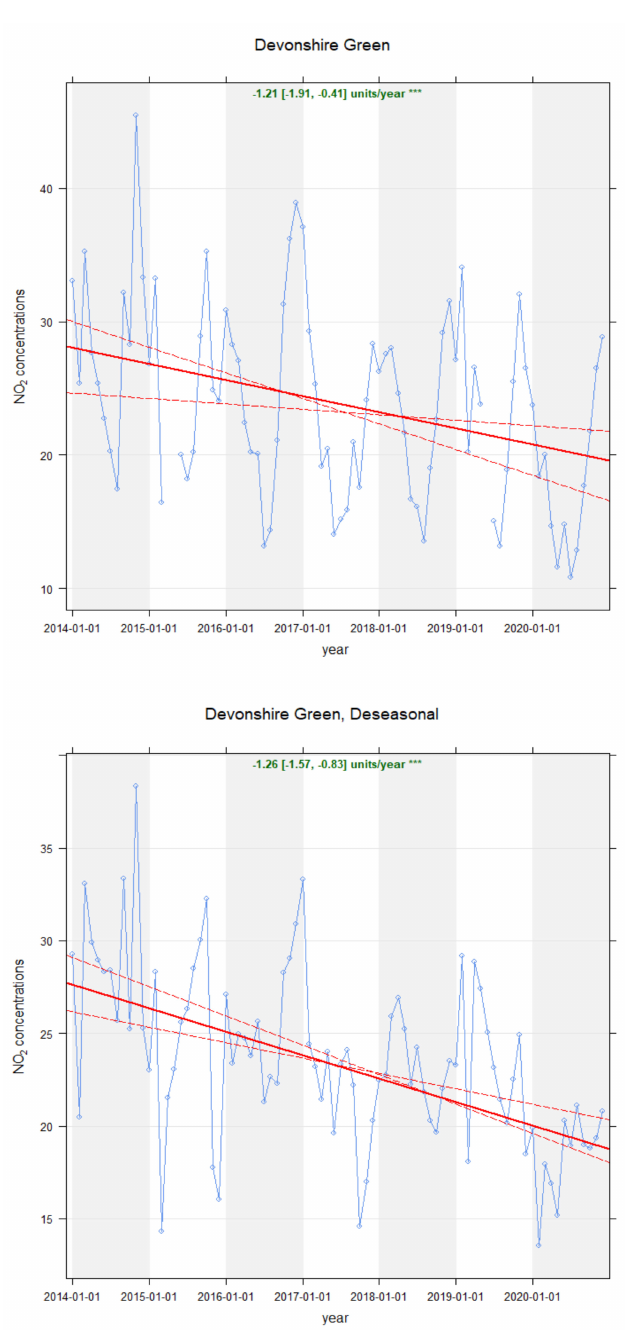
Figure 14. Long-term temporal trend for NO 2 concentrations ( µ g/m 3 ) (2014–2019) at the Sheffield Devonshire Green site. *** shows that the trend is highly